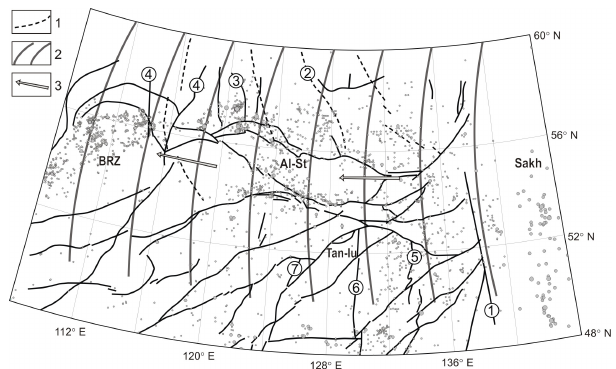
Figure 2. The spatial distribution of seismicity in the annual cy- cles with respect to the strain wave fronts and meridional struc- tures. Active tectonic faulting: Tanlu fault zone, Aldan–Stanovoy block (Al–St) and Baikal rift zone (BRZ). Figures in the circles denote the faults: 1 – Limurchan, 2 – Tyrkanda, 3 – Temulyakit meridional faults, 4 – meridional structures of the eastern flank of the Baikal rift zone, 5 – Gastakh, 6 – western Turanian, 7 – Levo- Minsky. 1 – submeridional interblock faults of the Aldan shield; 2 – strain wave fronts (Sherman, 2013); 3 – the direction of seismicity maxima migration in the annual cycles and movements of the strain wave